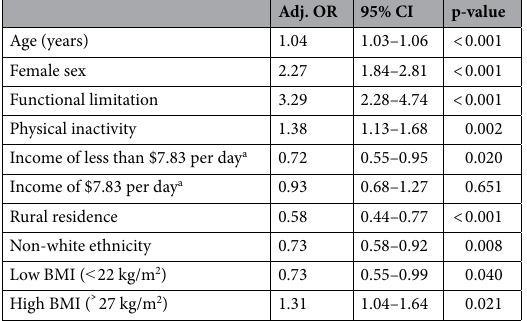
Table 3. Adjusted associations between individual variables and MM using a multiple logistic stepwise model. BMI Body Mass Index. a Dollar values for year 2015.